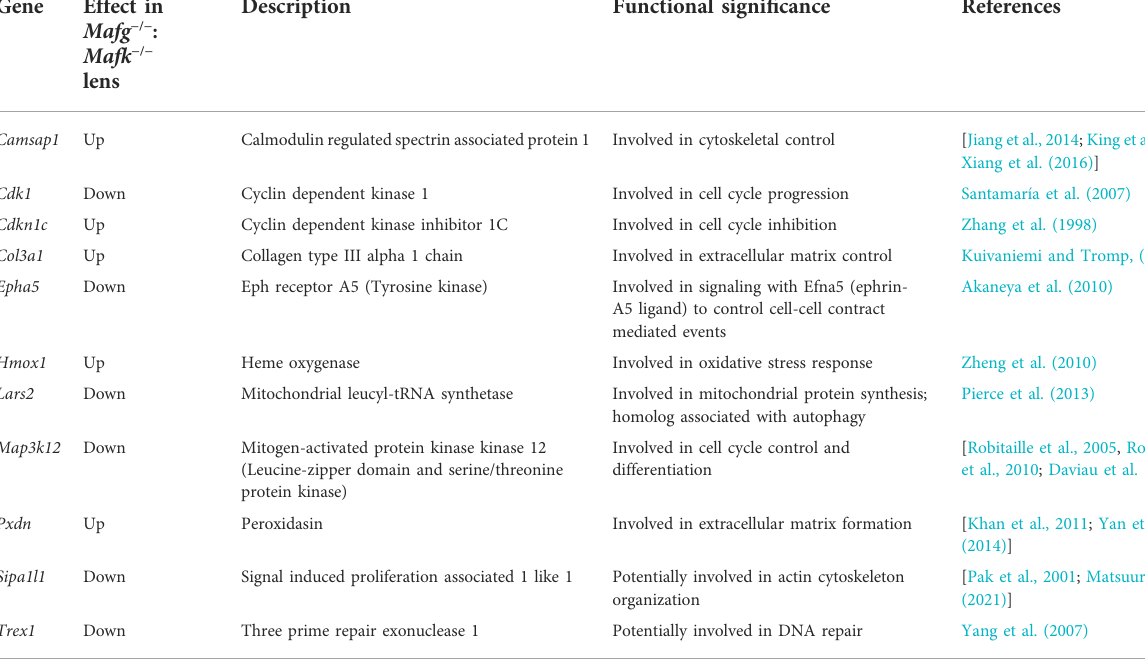
TABLE 3 Functional signi fi cance of select Mafg − / − : Mafk − / − differentially expressed candidates. Gene Effect in Mafg − / −